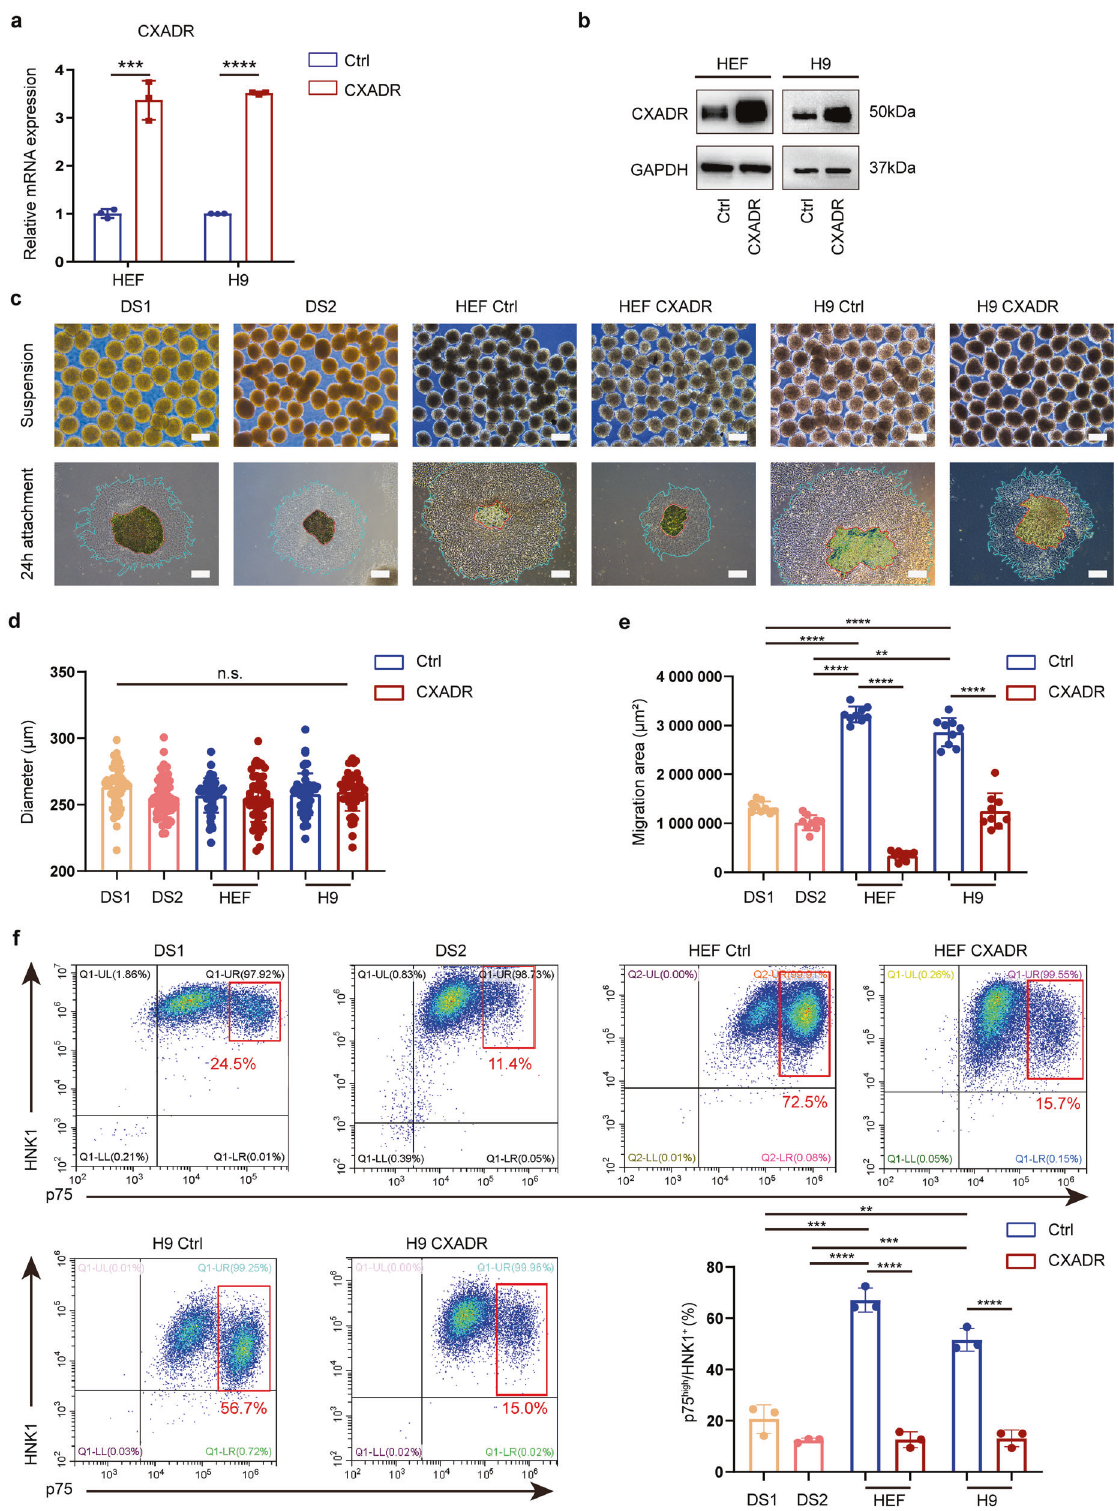
Fig. 7 Overexpression of CXADR impaired the migratory capacity of control NCSCs. a qPCR assay for CXADR expression in the control hPSCs after lentiviral transduction. b Protein expression of CXADR was evaluated after lentiviral transduction. c Spheres were formed by day 7 differentiated cells from different groups (DS group, Ctrl euploid group, and CXADR-overexpression euploid group) and then grew in attachment culture for 24 h. Scale bar: 250 μ m. d The diameter of the spheres formed by day 7 differentiated cells were calculated and compared between different groups. n = 50. e The cell migration area was quanti fi ed and compared between different groups. n = 12. f The percentage of postmigratory NCSCs (p75 high /HNK1 + ) derived from between different groups was detected by FACS. n = 3. Data are presented as the mean ± SD of three independent experiments. * P < 0.05, ** P < 0.01, *** P < 0.001, **** P < 0.0001, one-way ANOVA ( d ) and two-tailed unpaired Student ’ s t test ( a , e , f